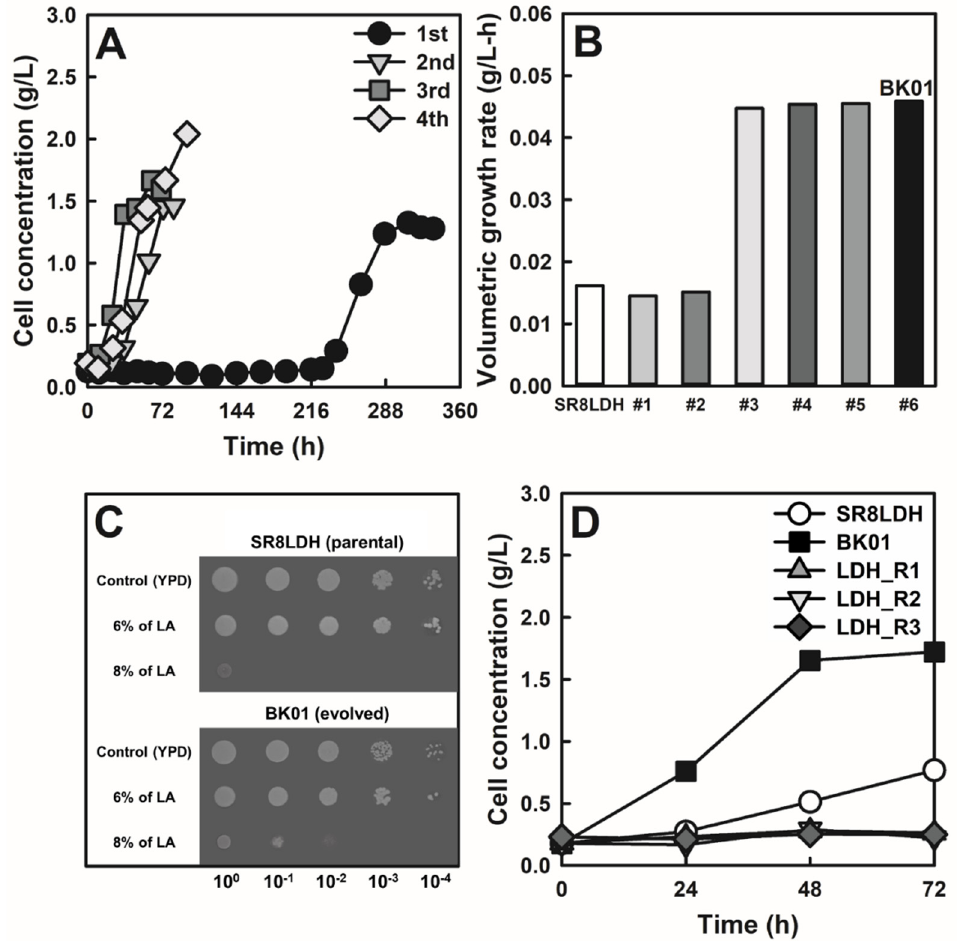
Figure 1. Adaptive laboratory evolution (ALE) of the lactic acid-producing S. cerevisiae SR8LDH strain in a high concentration of lactic acid and isolation of the lactic acid-tolerant BK01 strain. ( A ) Cell concentrations were monitored during four consecutive subcultures of SR8LDH in complex medium containing 20 g/L glucose and 8% lactic acid. ( B ) Comparison of volumetric growth rates (g/L-h) of six evolved SR8LDH strains (#1–#6) in 8% lactic acid and the selection of a representative evolved strain, BK01 (#6). ( C ) Spotting assay of SR8LDH and BK01 on complex agar medium containing 20 g/L glucose and 0%, 6%, and 8% lactic acid. ( D ) Growth rate comparisons of SR8LDH, BK01, and the reverse-engineered strains (described in Table 1) in complex medium containing 20 g/L glucose and 8% lactic acid. All experiments were conducted under oxygen-limited conditions (80 rpm), with an initial cell concentration of 0.05 g DCW/L.